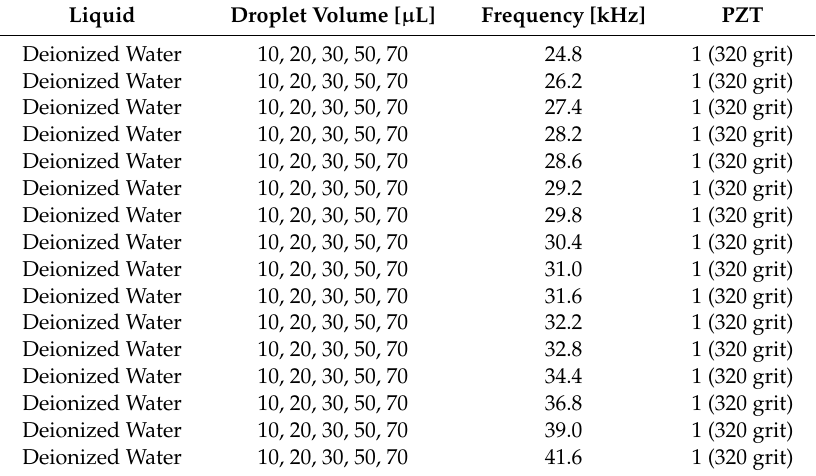
Table A7. Testing parameters used for the experiments conducted with deionized water to investigate the e ff ects of surface roughness using 320 grit sandpaper.